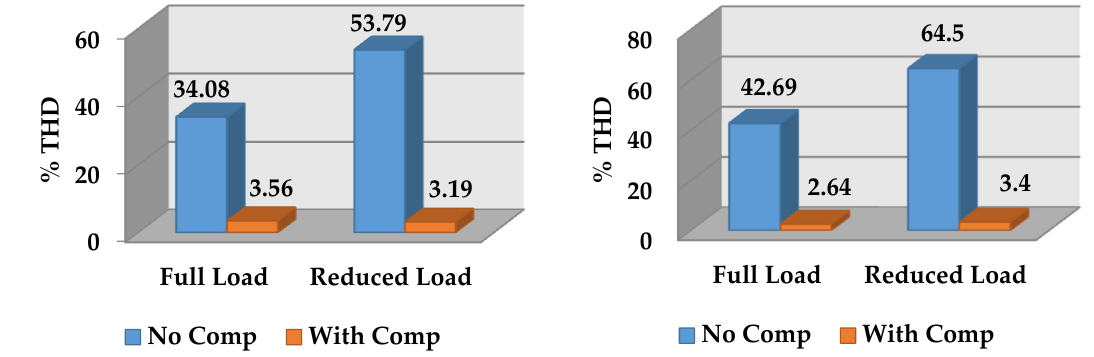
Figure 19. %THD at PCC using VDB-HCC: ( a ) ideal grid condition; ( b ) distorted grid condition.